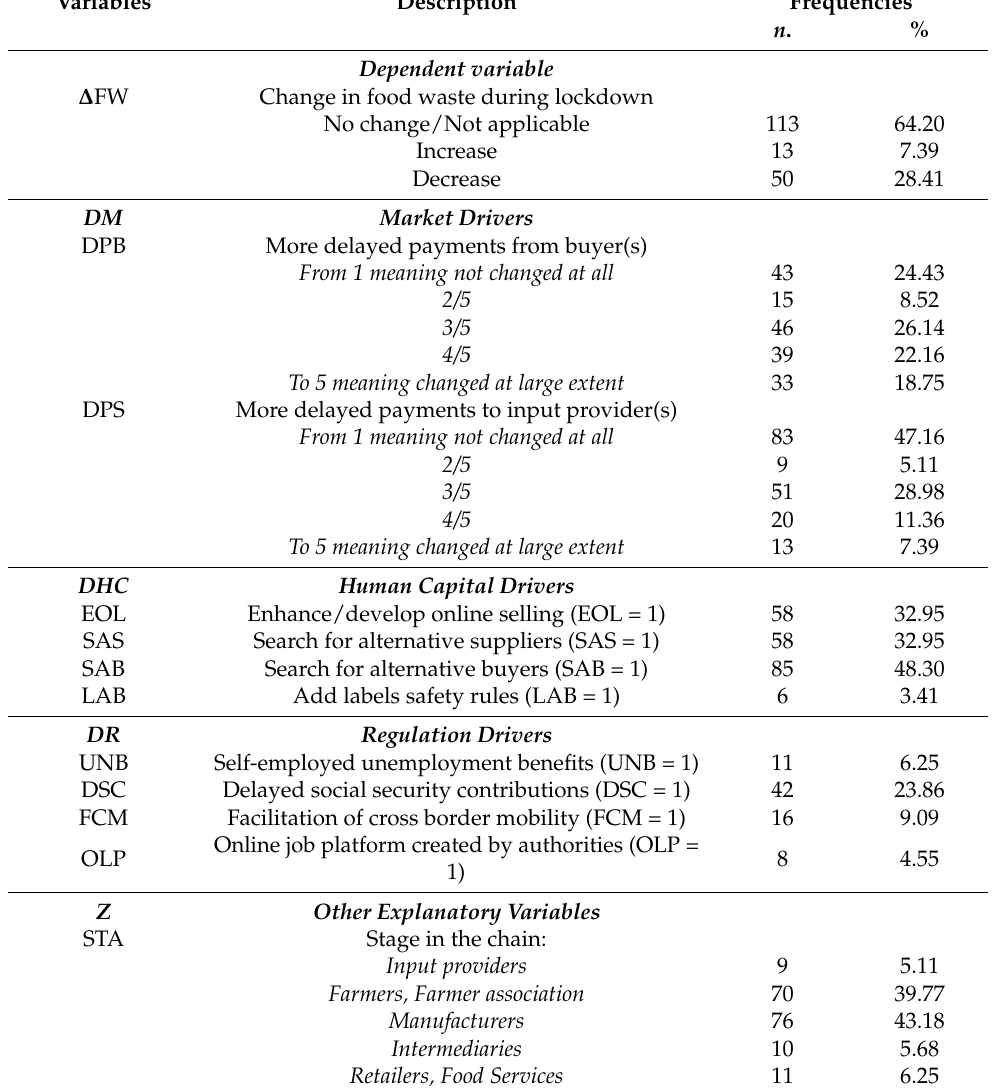
Table 3. Sample characteristics ( n =